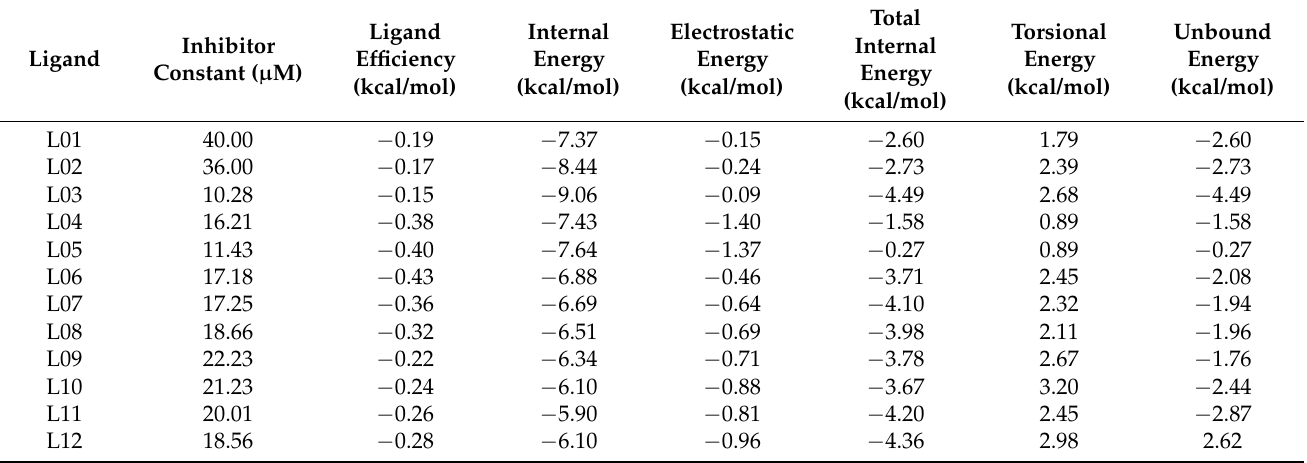
Table 5. Data of inhibition constant, binding energy, efficiency, and total energy of